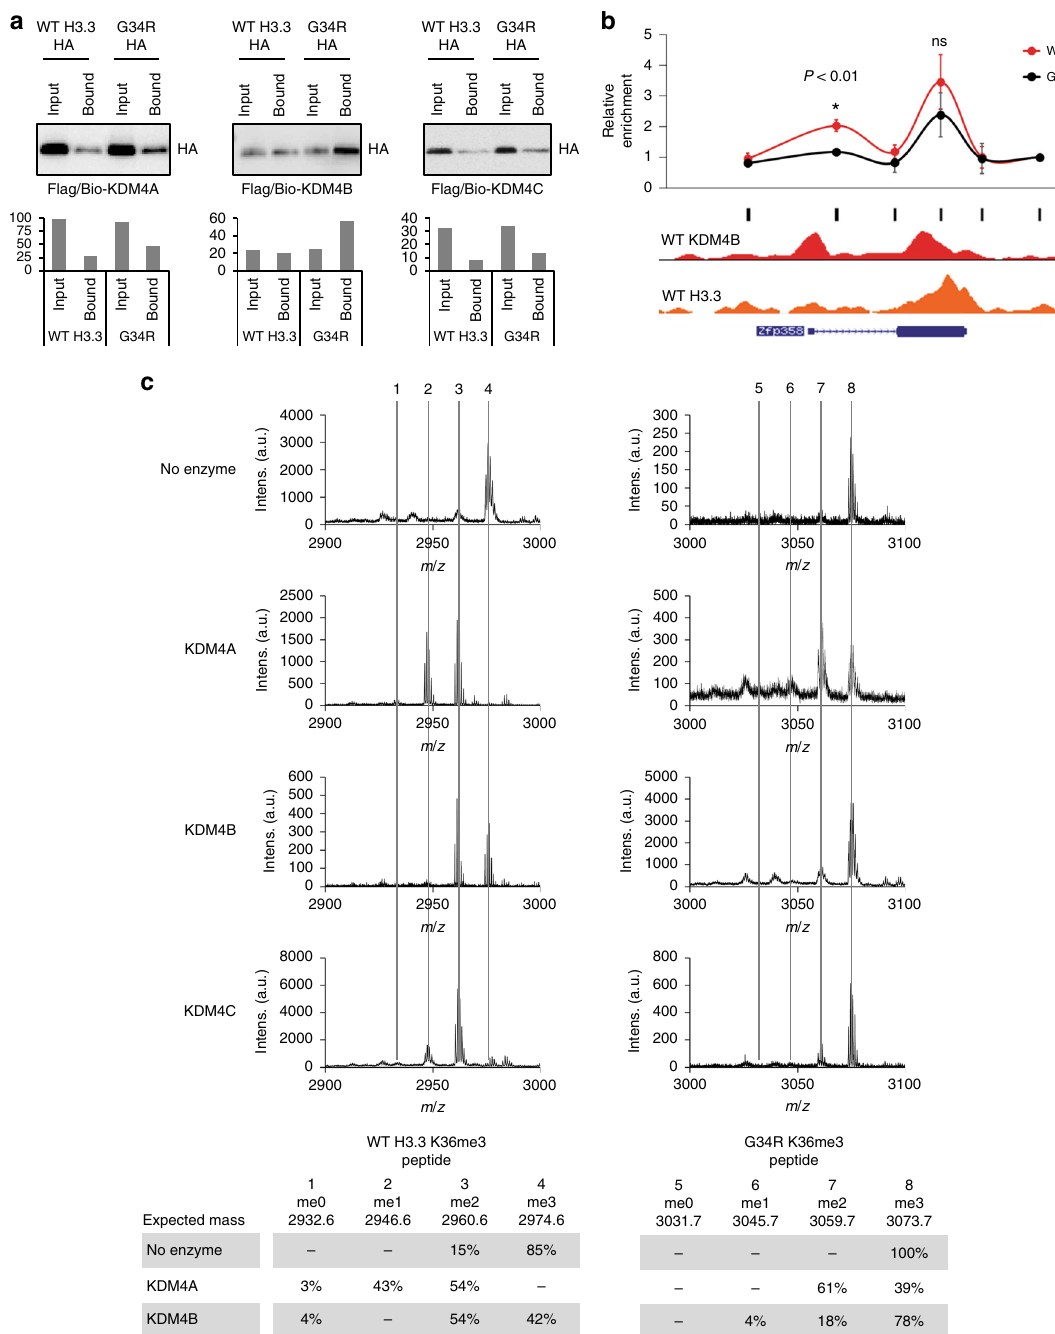
Fig. 4 H3.3 G34R preferentially binds to KDM4 and inhibits its demethylase activity. a Protein pulldowns of KDM4-A, -B and -C, immunoblotted with anti- HA for detection of HA-tagged WT H3.3 and H3.3 G34R. Representative blots are shown and quantitation values are shown. b ChIP-qPCR of KDM4B in WT and G34R cells tiled across a representative gene, Zfp358 . Results are normalised for input and values represent mean enrichment of three independent experiments, calculated relative to a negative control ( Zfp358 , primers 6). Data are mean average and error bars are standard deviations of three independent experiments ( n = 3). P -values calculated using Student ’ s T -test (* P < 0.01). Black bars indicate primer locations. ChIP-seq pro fi les of KDM4B and H3.3 in WT cells across the gene are shown. c Mass spectrometry analysis of in vitro demethylase assays. KDM4-A, -B and -C were combined with either WT H3.3 K36me3 peptide (left panel) or a G34R K36me3 peptide (right panel). Dashed lines indicate expected masses for K36 me0, me1, me2 and